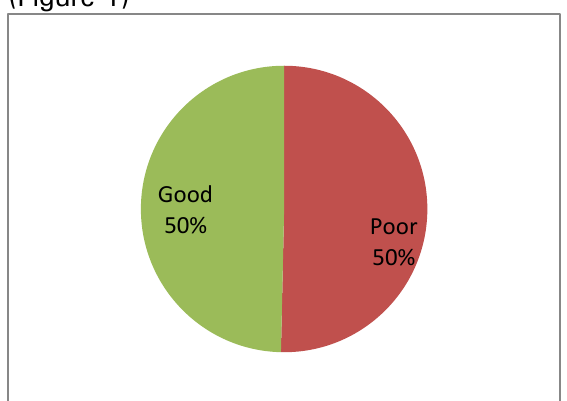
Figure 1 Pie chart showing the Level of Overall Self-care Activities of the